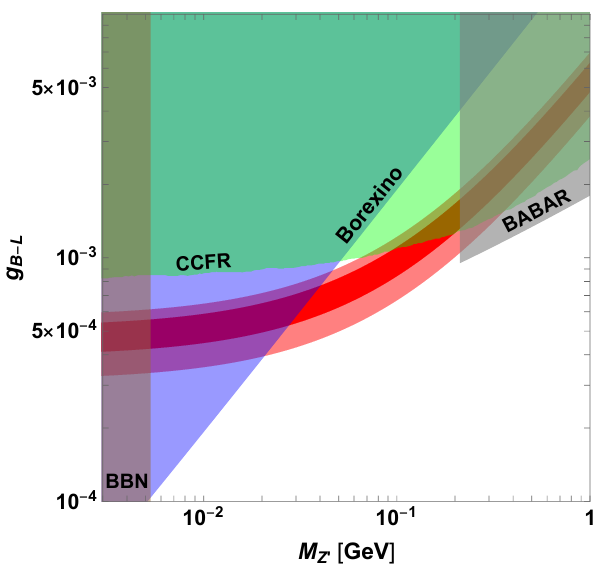
Figure 1 . Allowed parameter space on the M Z 0 (cid:0) g B (cid:0) L plane with relevant constraints. The favored regions for (cid:1) a (cid:22) (cid:17) a exp (cid:0) a SM from eq. (3.3) are shown by the red (1 (cid:27) ) and pink (2 (cid:27) ) bands. (cid:22) (cid:22) The other shaded regions show the constraints from CCFR (green) [28], BaBar (gray) [29], BBN (brown) [30{32] and Borexino with M U = 1 TeV (blue) [64{66]. The current deviation (cid:1) a (cid:17) a exp (cid:22)